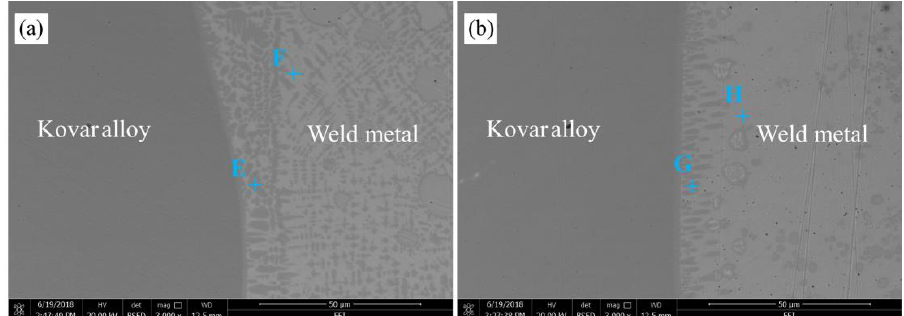
Figure 6. Microstructure of the kovar alloy side interface of welded joints at welding speeds of ( a ) 6 mm/s (EBW-1) and ( b ) 10 mm/s (EBW-3). Table 5. The main chemical compositions of different zones (at %) at the kovar alloy side. Zone Ti